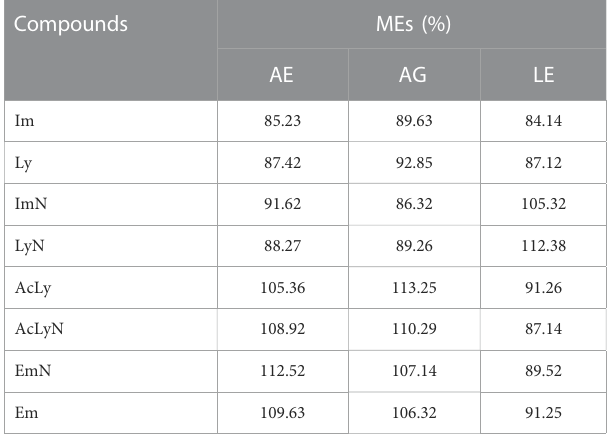
TABLE 5 MEs (%) of 8 PAs in three Zicao by the established UPLC-MS/MS.